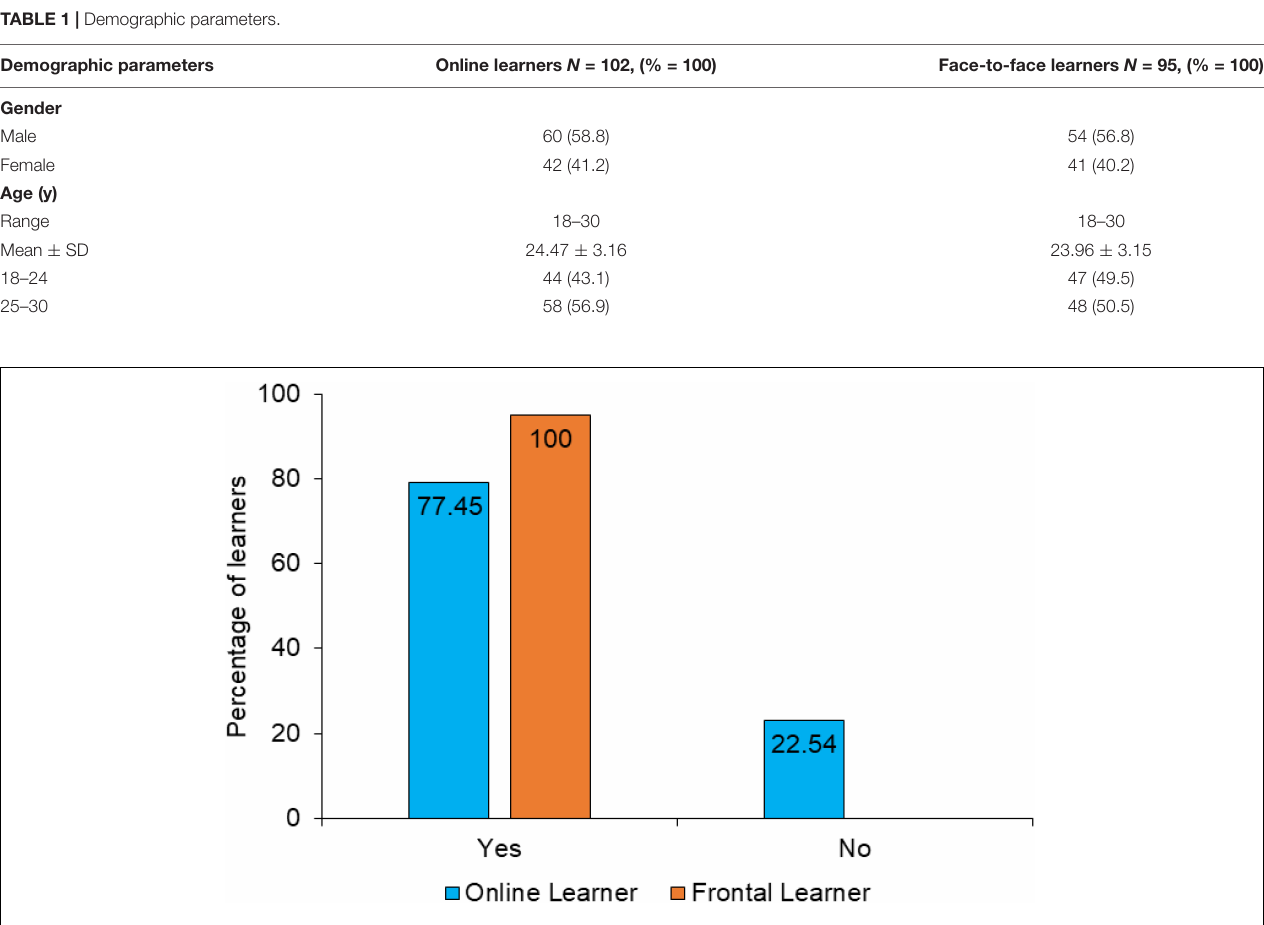
FIGURE 2 | Percentages of learners with previous experience of online learning.